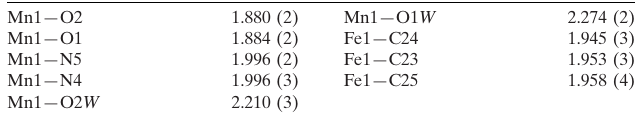
Selected bond lengths (A˚ ).